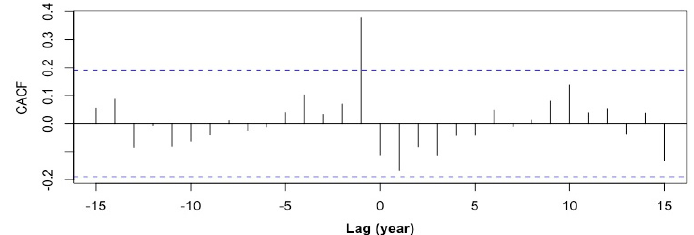
Figure 3. The cross-autocorrelation function (CACF) of the differenced Colorado River and Great Salt Lake (GSL) series. Note the significant cross-autocorrelation at lag − 1. The two blue dashed lines denote the 95% confidence interval.